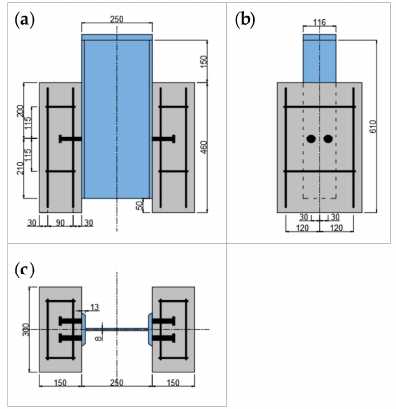
Figure 2. Fabrication of push-out specimen: ( a ) welding studs; ( b ) concrete pouring; ( c ) concrete curing; ( d ) welding steel plates. 2.2. Material Properties After 28 days of curing, the average concrete cube strength and elastic modulus were 42.3 MPa and 3.31 × 10 4 MPa, respectively. The material test results of the steel beam, stud, and reinforcement mesh are shown in Table 2. Table 2. Material test results. Project